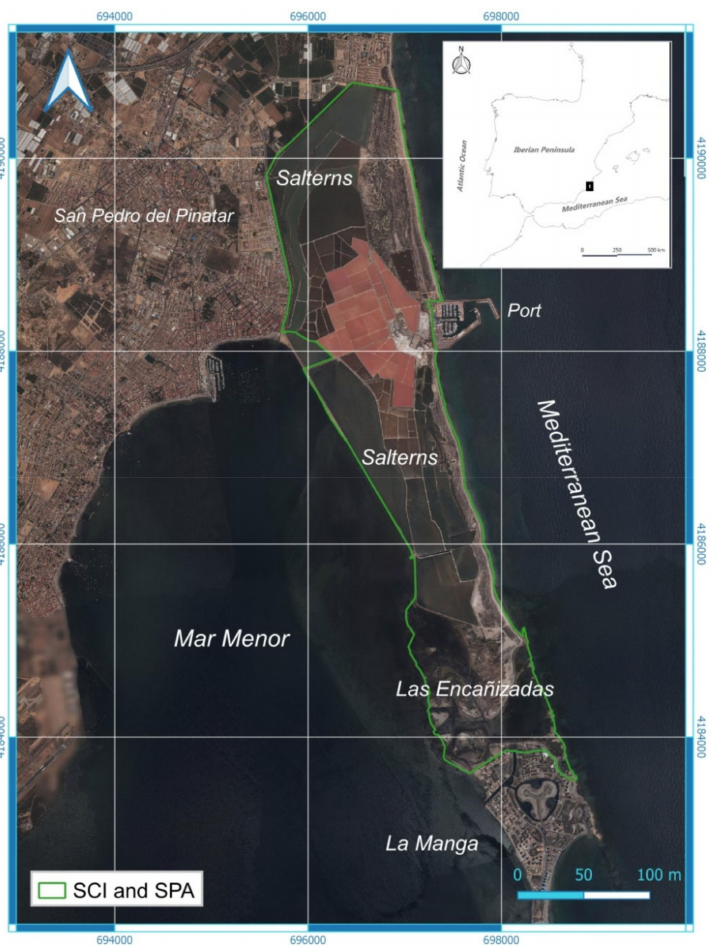
Figure 1. Regional Park of the Salinas and Arenales de San Pedro del Pinatar (Source: own